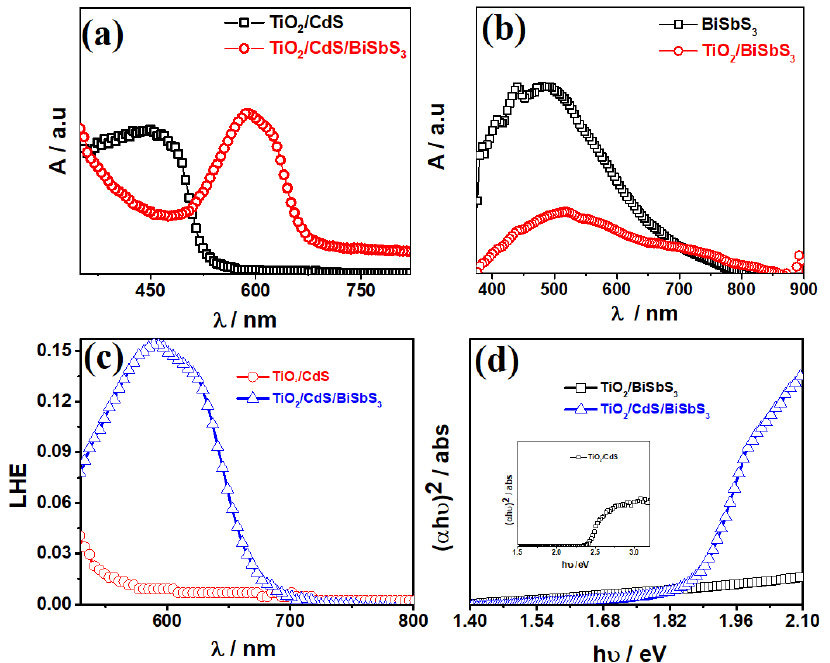
Figure 1. Fabricated electrodes ( a , b ), UV-Visible spectra ( c ) LHE efficiency, and ( d ) Tauc’s plots.